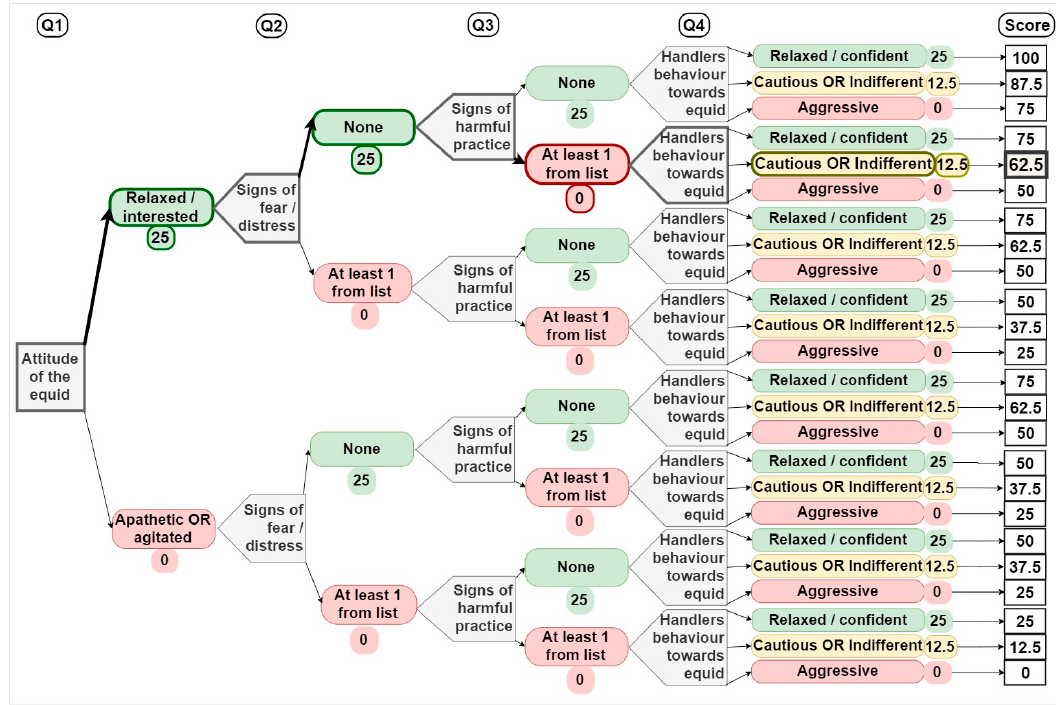
Figure 1. Example decision-tree for the behavior category. Each question scores a maximum of 25 points. Points are summed for all four questions to give the category score. In the example above (indicated by bold arrows and boxes), an equid that was assigned a ‘green’ answer for Q1 and Q2, red for Q3, and amber for Q4 would score a total of 62.5 points. The full list of answers for Q2 and Q3 are provided in Table 1.